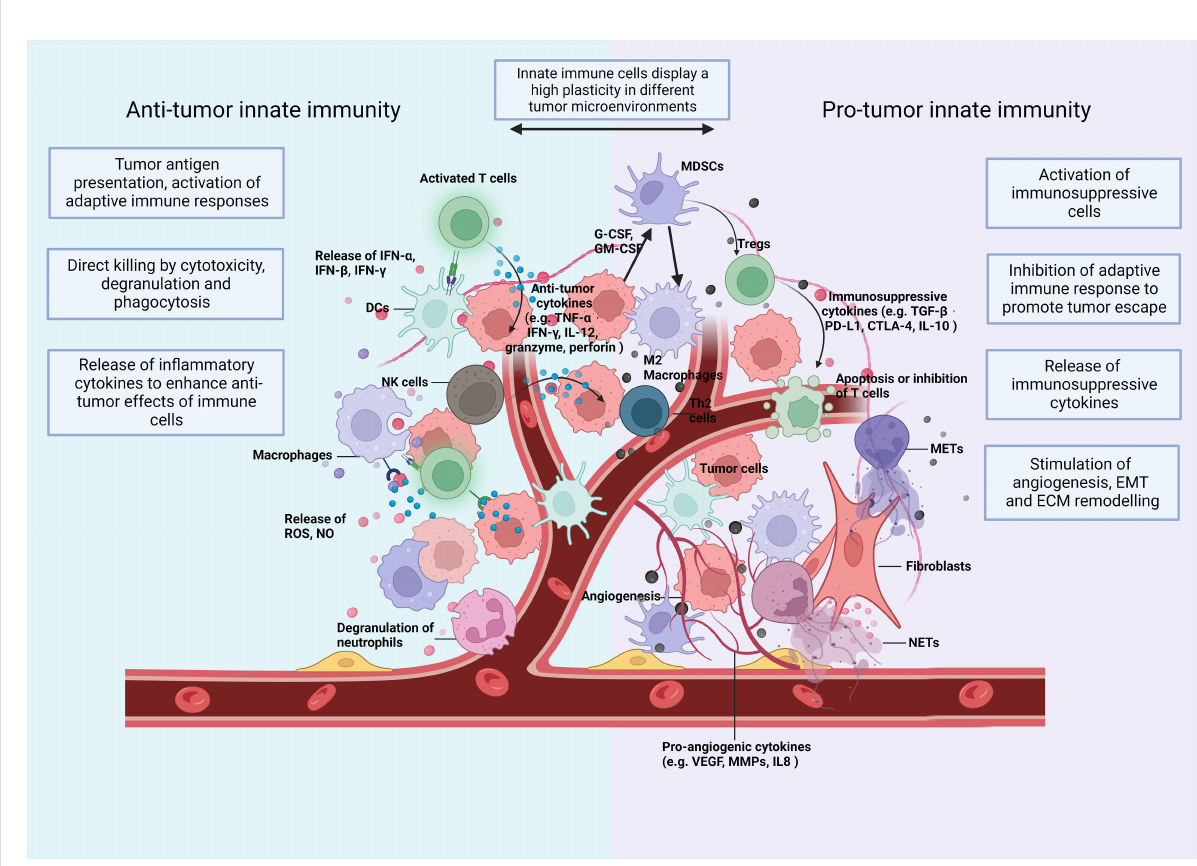
FIGURE 1 The TIME: Immune cells and soluble mediators shape the diversity of the TIME. Innate immunity plays multiple roles in cancer and shows a high plasticity depending on changes of the TIME. In Anti-tumorigenic TIMEs, innate immune cells (1) recognize and present tumor cell-derived antigenic peptides to T cells and activate the adaptive immunity (2); eliminate tumor cells directly by phagocytosis and secrete cytotoxic substances, like perforin and granzyme (3); secrete proin fl ammatory cytokines and, thus, expand and promote a wide variety of Anti-tumor responses. In a Pro-tumorigenic TIME, innate immune cells (1) differentiate towards an immunosuppressive phenotype with the release of immunosuppressive cytokines (2); induce the in fi ltration of immunosuppressive adaptive immune cells, such as Tregs and Th2 cells (3); increase the formation of extracellular traps (ETs); and (4) promote angiogenesis (5), epithelial-mesenchymal transition (EMT) and (6) extracellular matrix (ECM) remodelling. Consequently, they enhance tumor invasion and migration. The plasticity of innate immunity allows remodelling of the TIME. CTLA-4, cytotoxic T lymphocyte associated antigen 4; DCs, dendritic cells; ECM, extracellular matrix; EMT, epithelial mesenchymal transition; G-CSF, granulocyte colony stimulating factor; GM-CSF, granulocyte-macrophage colony stimulating factor; IFN, interferon; IL, interleukin; MDSC, myeloid-derived suppressor cells; METs, macrophage extracellular traps; MMPs, matrix metalloproteinases; NETs, neutrophil extracellular traps; NK, natural killing; NO, nitric oxide; PD-L1, programmed death-ligand 1; ROS, reactive oxygen species; TGF, transforming growth factor; TNF, tumor necrosis factor; VEGF, vascular endothelial growth